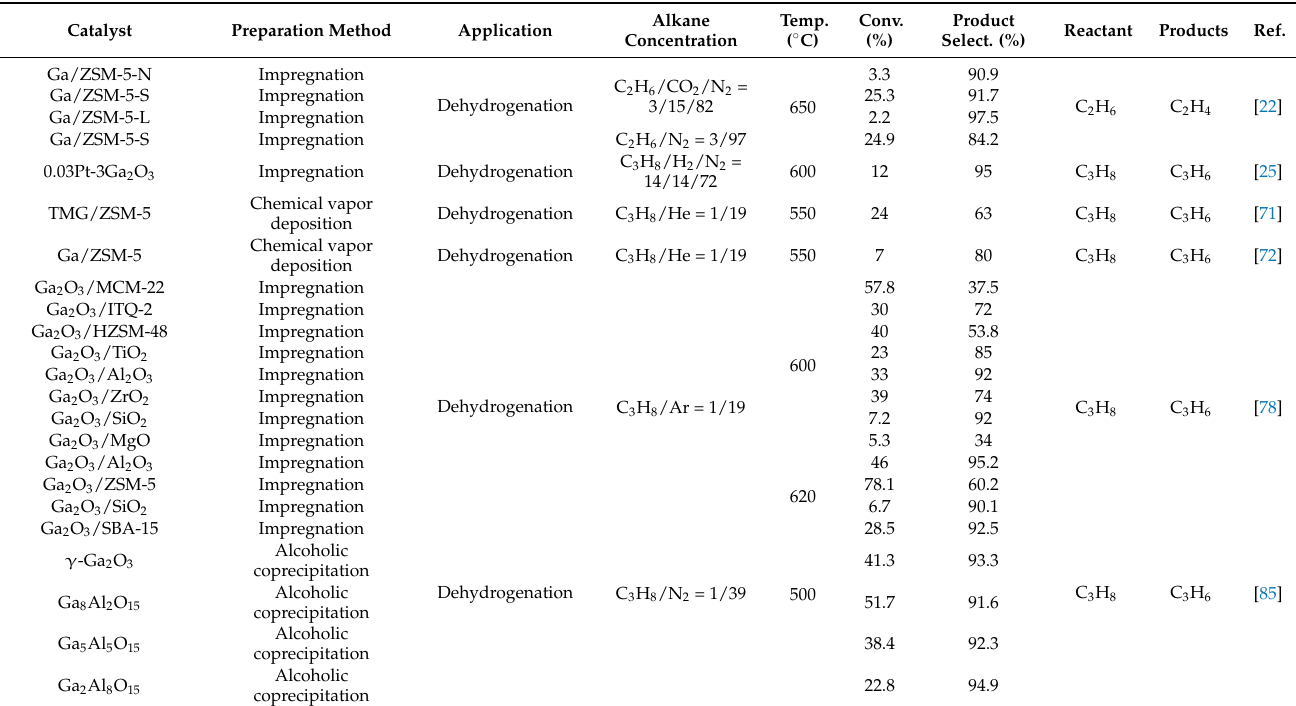
Table 2. Summary of the application of Ga-based catalysts on alkane